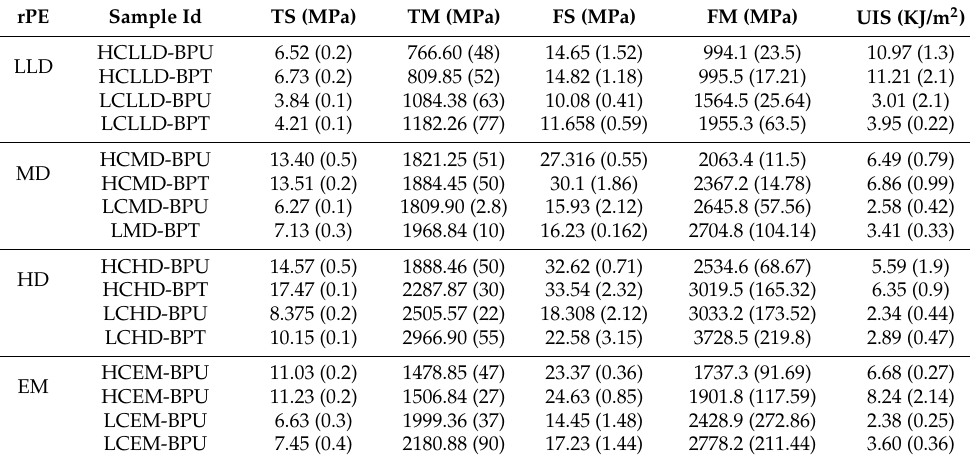
Table 8. Mechanical properties of WPC formulated from recycled PE plastics and